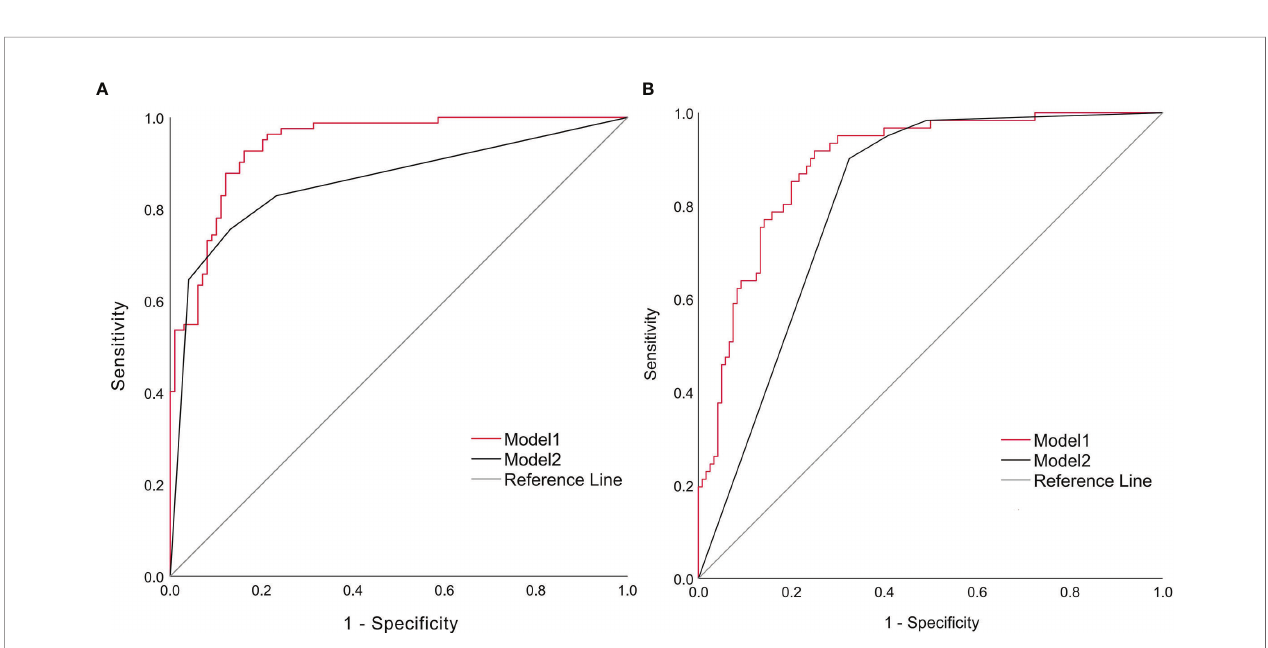
FIGURE 8 | ROC curves for assessing disease severity at admission (A) and predicting short-term prognosis (B) ROC, receiver operating